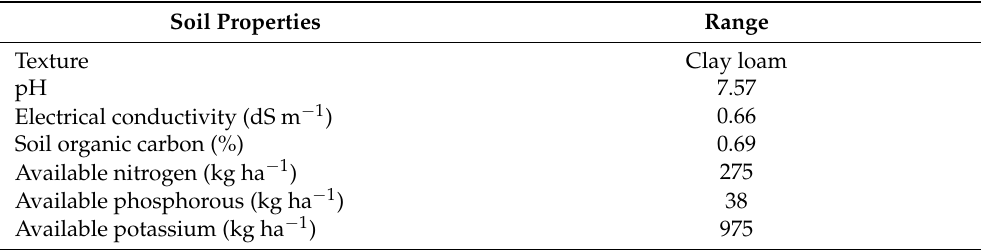
Table 1. Physiochemical properties of soil.